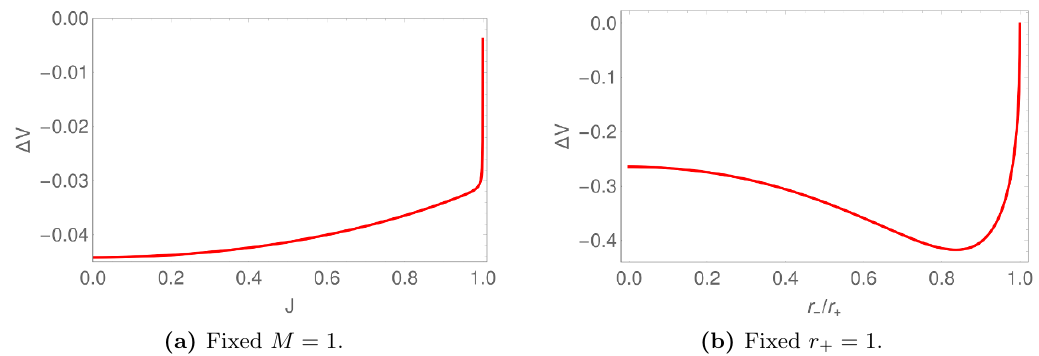
Figure 4 . Opening of the wormhole with temperature not (cid:12)xed. The wormhole closes as we approach the extremal limit. We have set (cid:1) = 0 :